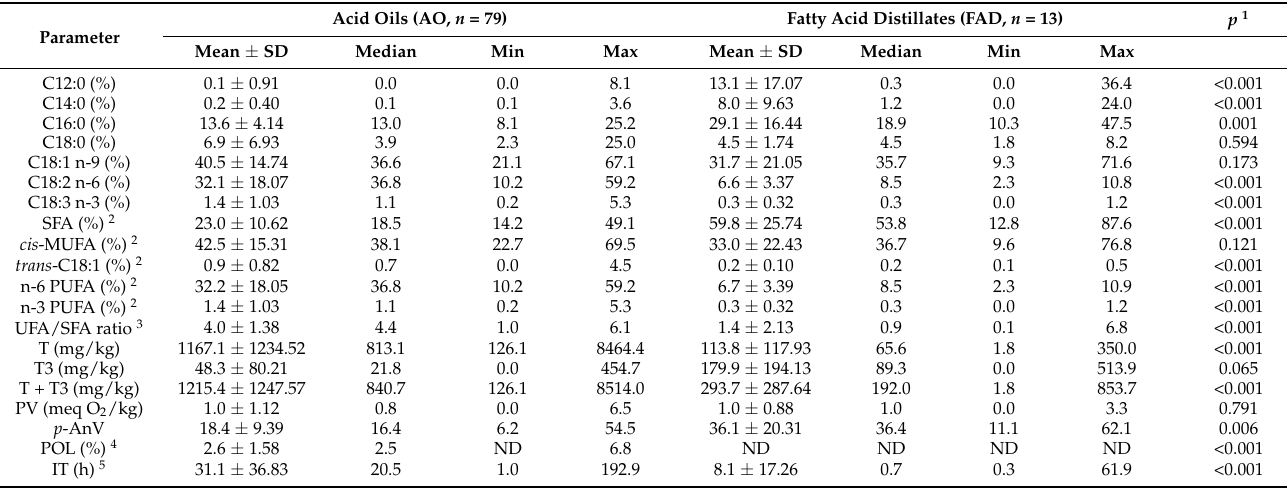
Table 2. Mean, standard deviation, median, minimum, and maximum values obtained for acid oils (AO) from chemical refining and fatty acid distillates (FAD) from physical refining. Acid Oils (AO, n = 79) Fatty Acid Distillates (FAD, n = 13) p Parameter